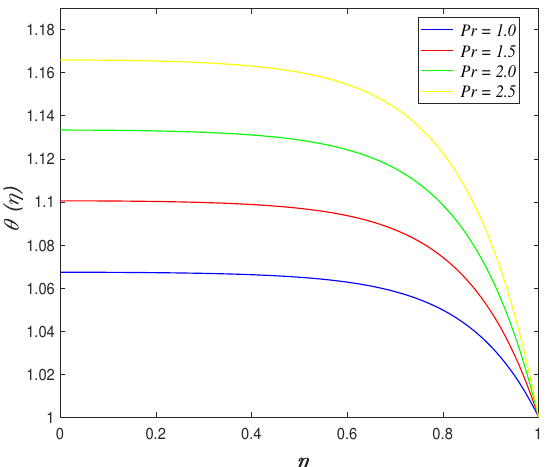
Figure 17. Impact of Pr on